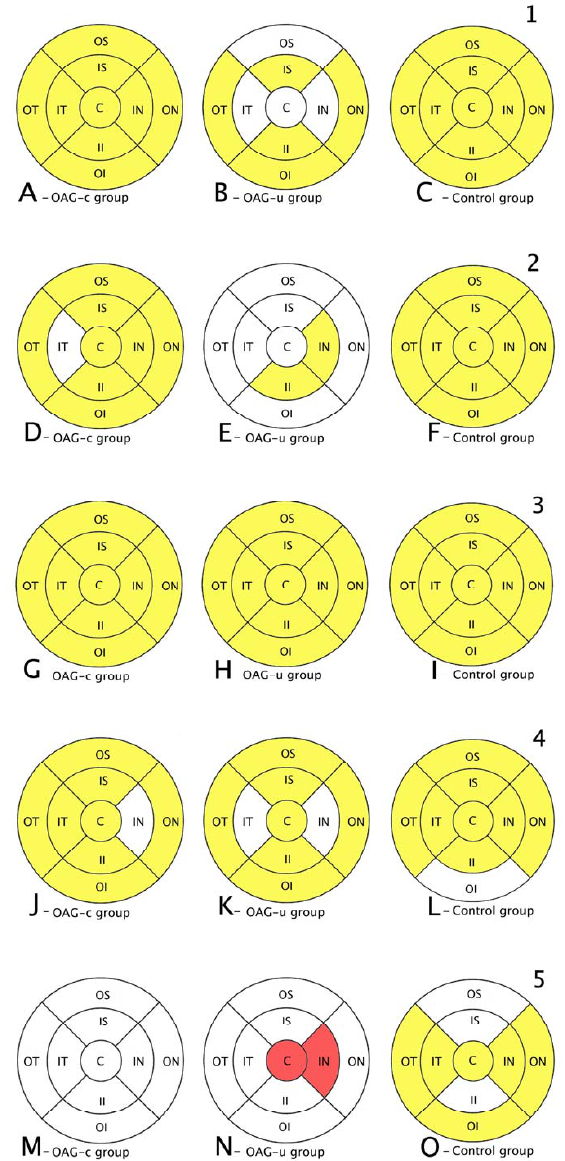
Figure 9. Comparison of posterior segment OCT results in ETDRS–9 subsegments and retinal layers before and 6 months after the cataract surgery between control and OAG c or OAG u groups. ( A – C ) total macular thickness, ( D – F ) RNFL thickness, ( G – I ) GCL++ thickness, ( J – L ) GCL+ thickness, ( M – O ) choroid thickness. C—central, IS—inner superior, IN—inner nasal, II—inner inferior, IT—inner temporal, OS—outer superior, ON—outer nasal, OI—outer inferior, OT—outer temporal. Mean layer thickness is shown in ETDRS–9 subsegments. Colours mark statistically significant differences: yellow—statistically significantly higher mean thickness, red—statistically significantly lower mean thickness, white—statistically significant difference not